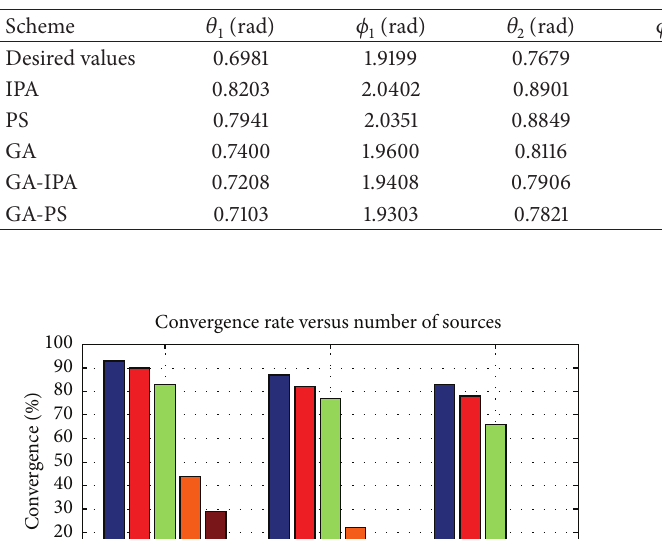
Table 6: Proximity effect of DOA of three sources and 17 sensors at SNR = 10 dB.